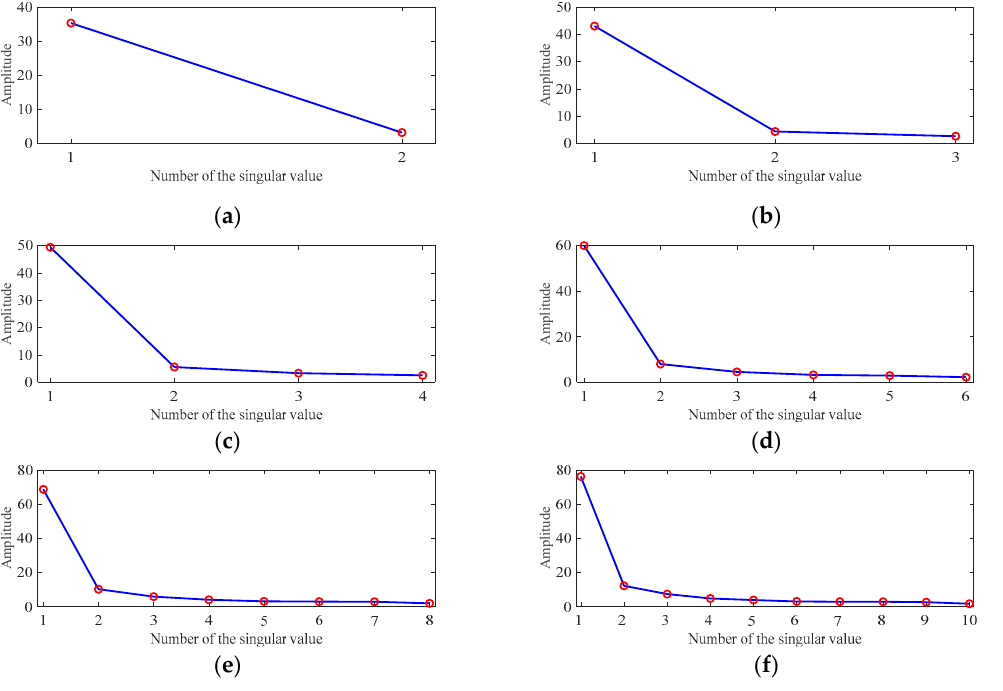
Figure 6. Eigenvalue spectra of different window lengths: ( a ) L = 2; ( b ) L = 3; ( c ) L = 4; ( d ) L = 6; ( e ) L = 8; ( f ) L = 10.